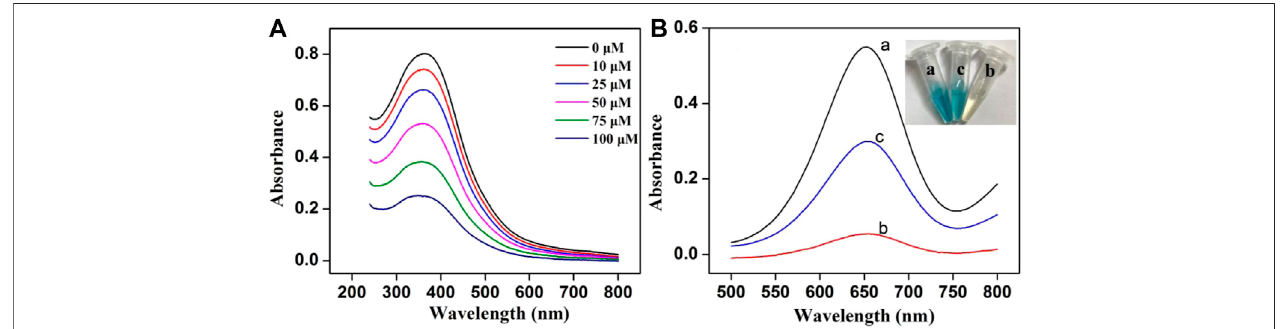
FIGURE 1 | (A) The UV-vis absorption spectra of MnO 2 NSs (162.5 μ g/mL) with different concentrations of GSH (B) Absorption spectra of the system under different conditions: (a) MnO